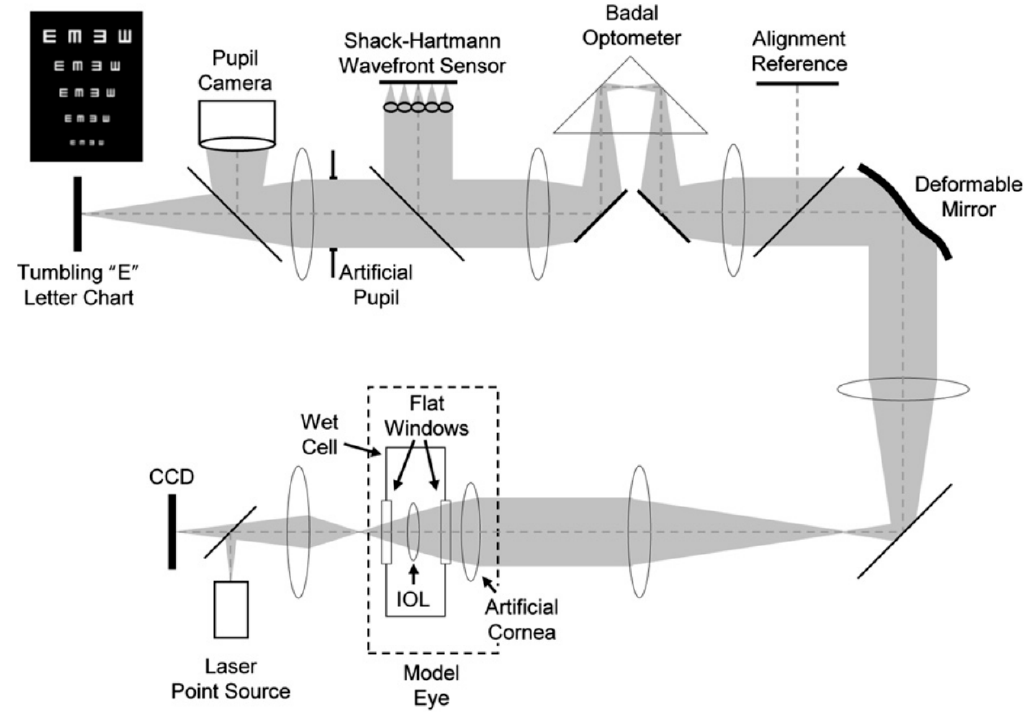
Figure 16. Complete adaptive optics IOL metrology system. Reprinted with permission from Ref.